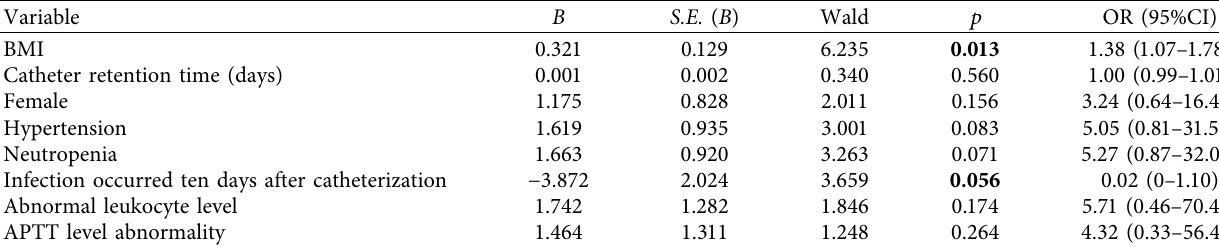
Table 2: Analysis of influencing factors for catheter-related blood source